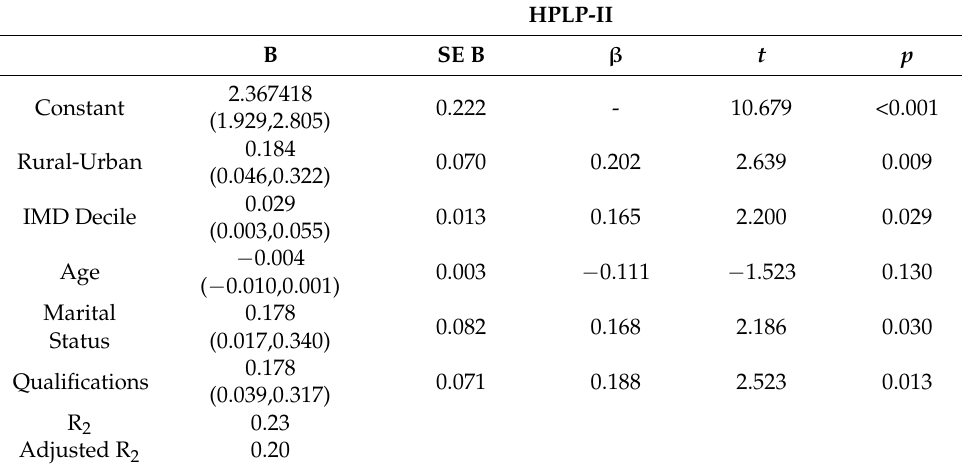
Table 4. HPLP II: multiple linear model of predictors of